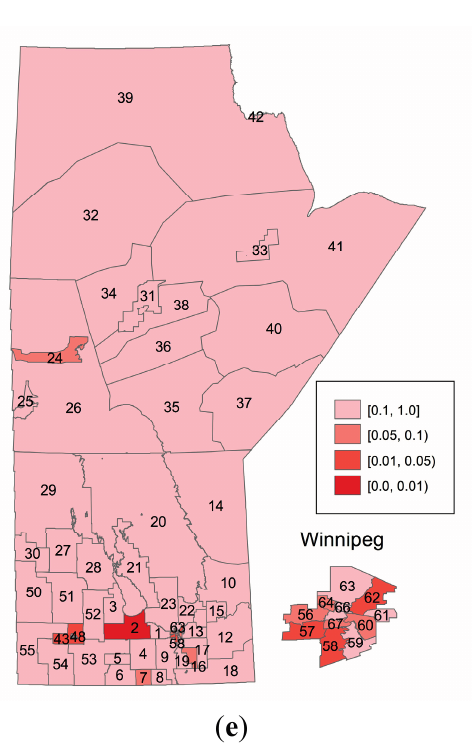
Figure 2. The order of most likely clusters of COPD for the CSS and FSS methods, and the special effects of the regional COPD risks for the BYM and MLE methods; in the case of cluster B. Major urban centre (Winnipeg region) is incorporated as an inset. ( a ) CSS; ( b ) FSS; ( c ) BYM; ( d )